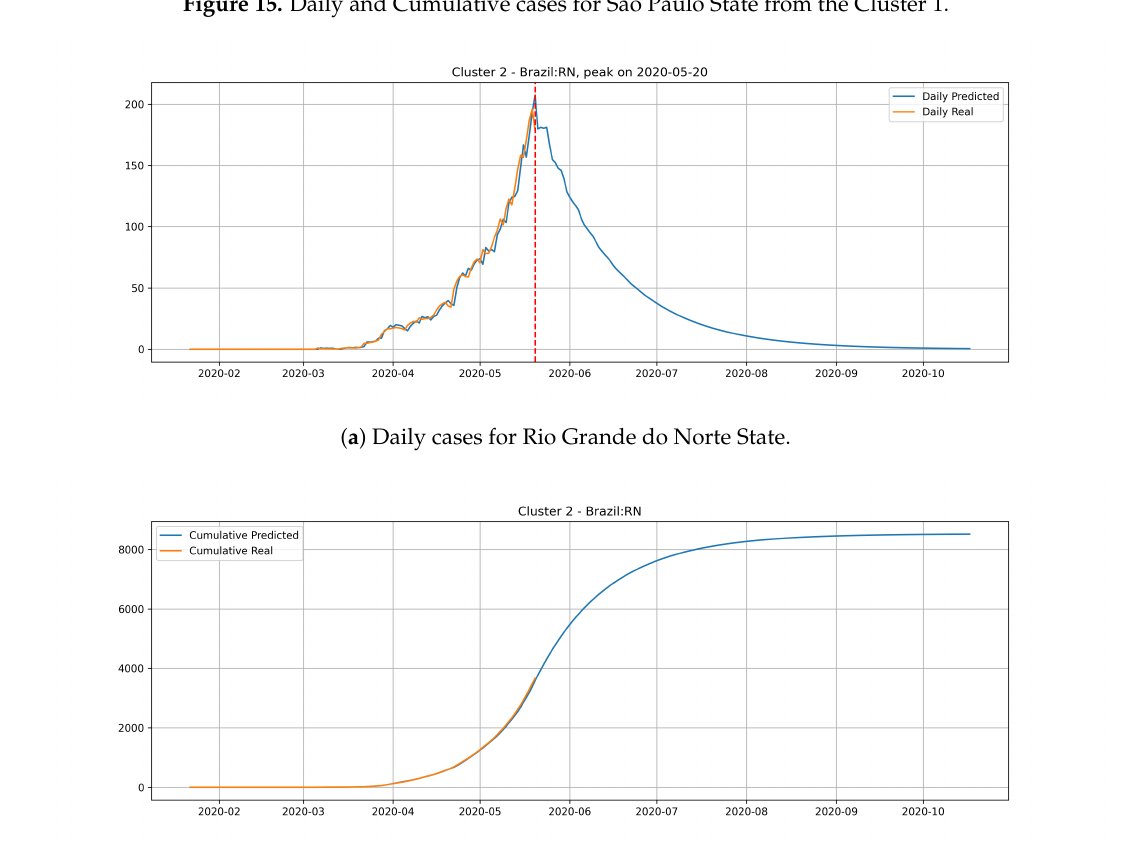
Figure 15. Daily and Cumulative cases for São Paulo State from the Cluster 1.